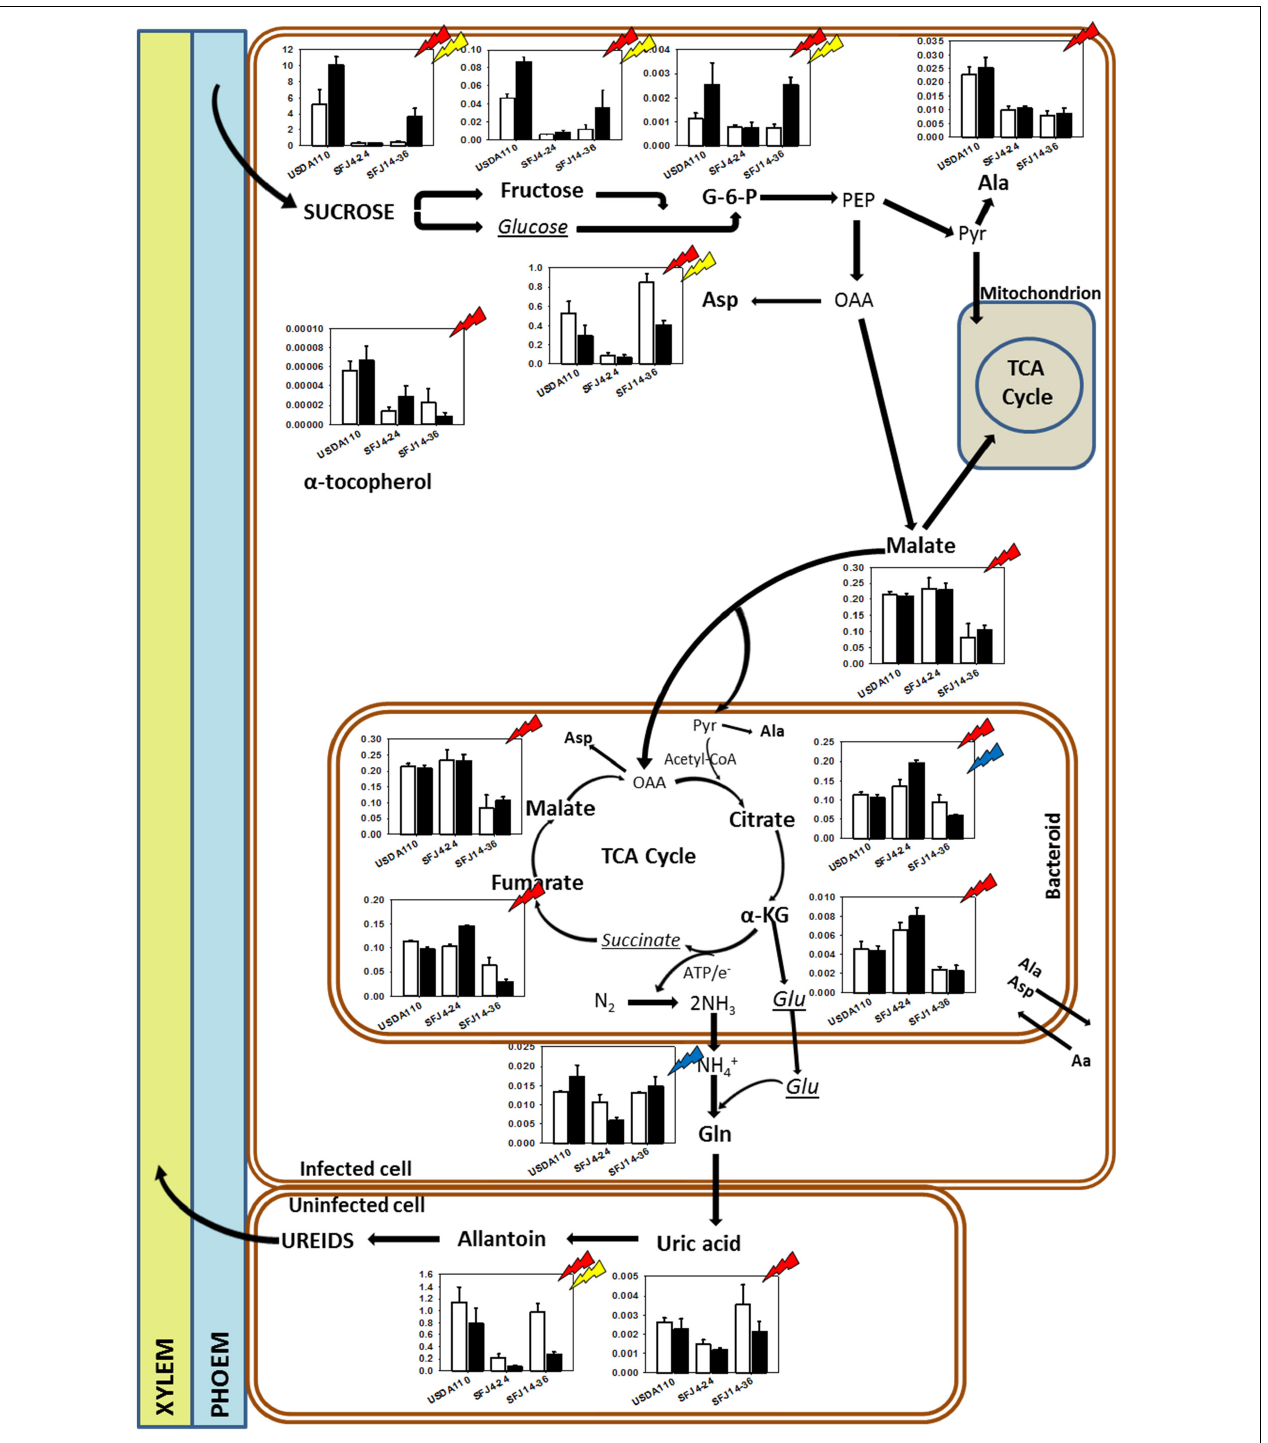
FIGURE 7 | Effects of Bradyrhizobium japonicum strain and [CO 2 ] on soybean nodule metabolism. Bar charts showing the relative abundance of metabolites in ambient [CO 2 ] (white) and elevated [CO 2 ] (black) in soybean plants inoculated with three different Bradyrhizobium japonicum strains. Red, yellow, and blue lightning signs indicate the significant effect of strain, CO 2 , and their interaction, respectively. Metabolites in bold indicate metabolites that were found to have significant effect of strain, CO 2 , and/or their interaction; italic metabolites indicate metabolites analyzed that were not found to have significant effect of strain, CO 2 , and their interaction, and not bold neither italic indicates metabolites not analyzed.